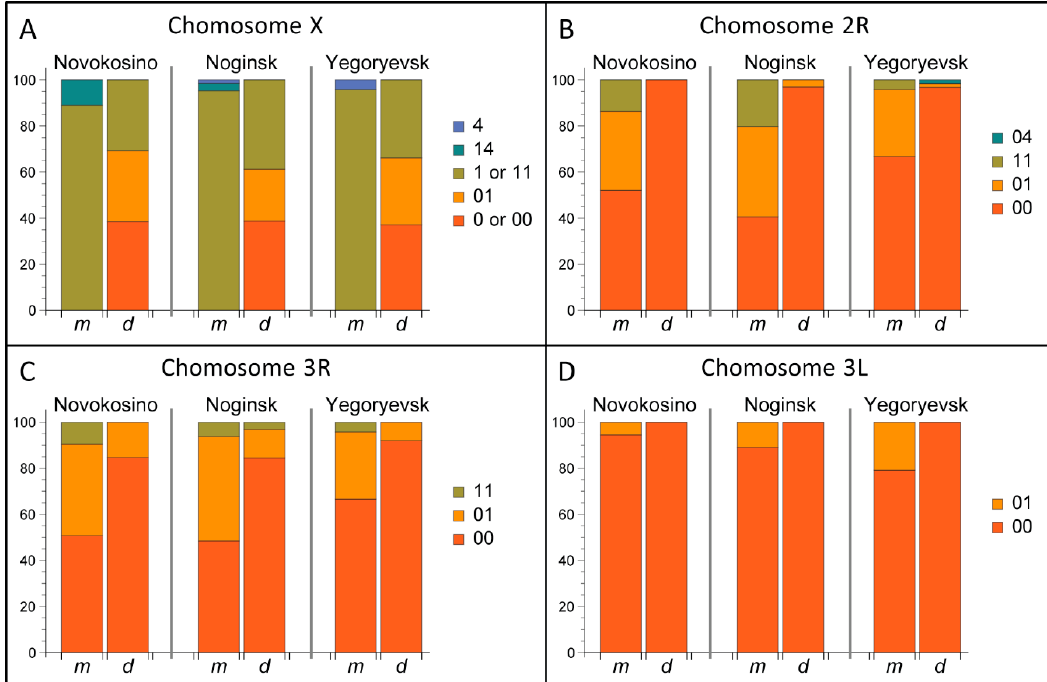
Figure 5. Inversion frequencies in An. messeae and An. daciae from the Novokosino, Noginsk, and Yegoryevsk populations . Frequencies of inversions: X0, X1, and X4 ( A ); 2R1 and 2R4 ( B ); 3R1 ( C ); and 3L1 ( D ) are shown by charts. Proportions of standard, inverted, and heterozygote arrangements are shown by different colors. Chromosome X is almost monomorphic in An. messeae but is highly polymorphic in An. daciae in the three Moscow populations. Although all autosomal inversions are present in both species, polymorphism is higher in An. messeae than in An. daciae . Rare inversions, X4 and 2R4, were found in low frequencies in An. messeae and An. daciae , respectively.